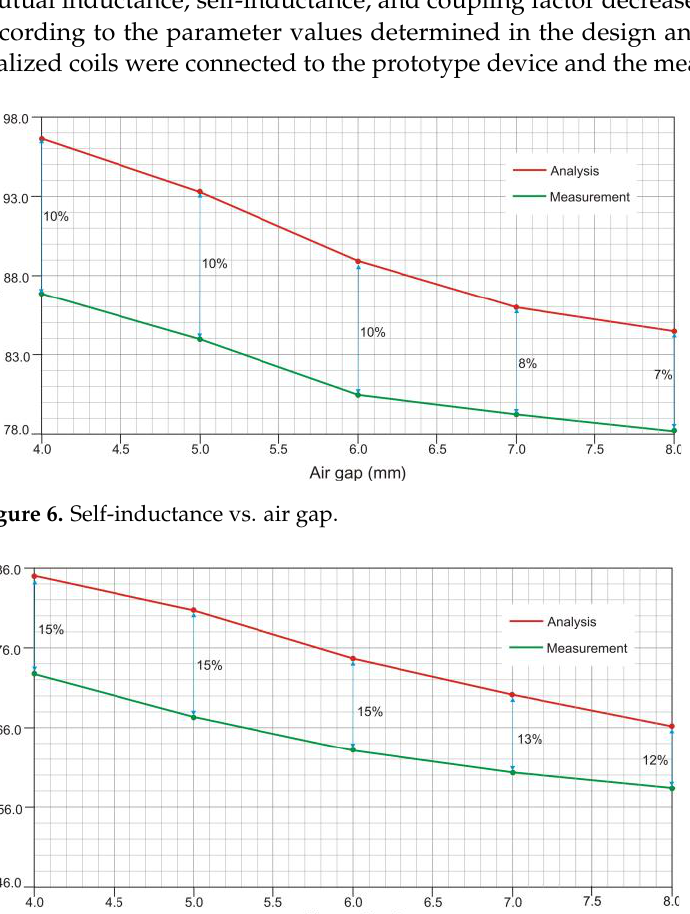
Figure 7. Mutual inductance vs. air gap.